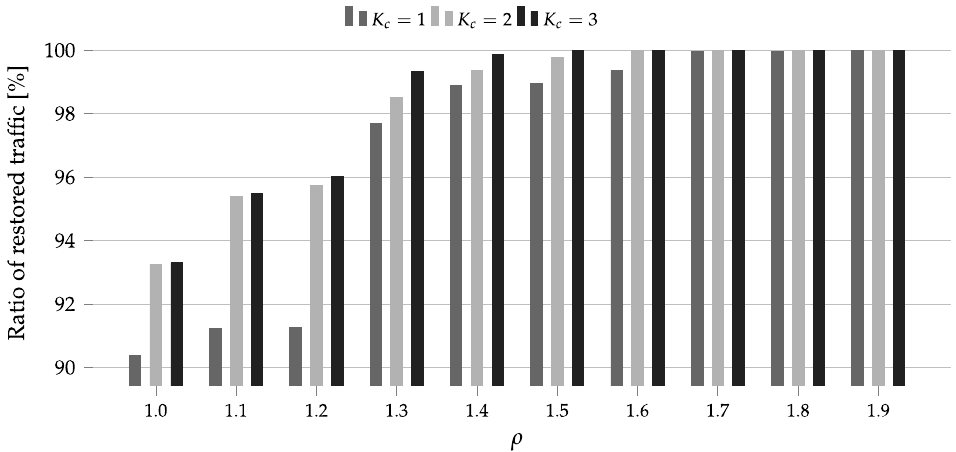
Figure 7. Ratio of the restored traffic for DT14 and 15 Tbps as a function of the amount of additional resources ρ .